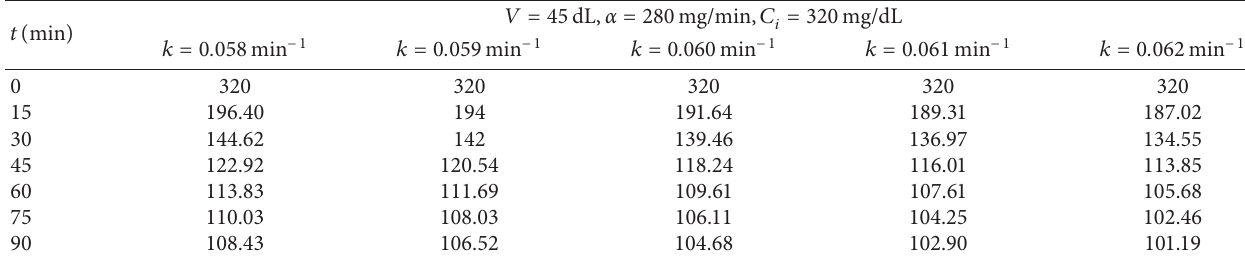
Table 6: Blood glucose concentration C ( t ) for different values of constant velocity of elimination k and time t with V � 45dL , α � 280mg/min , and C � 320mg/dL, see Figure i